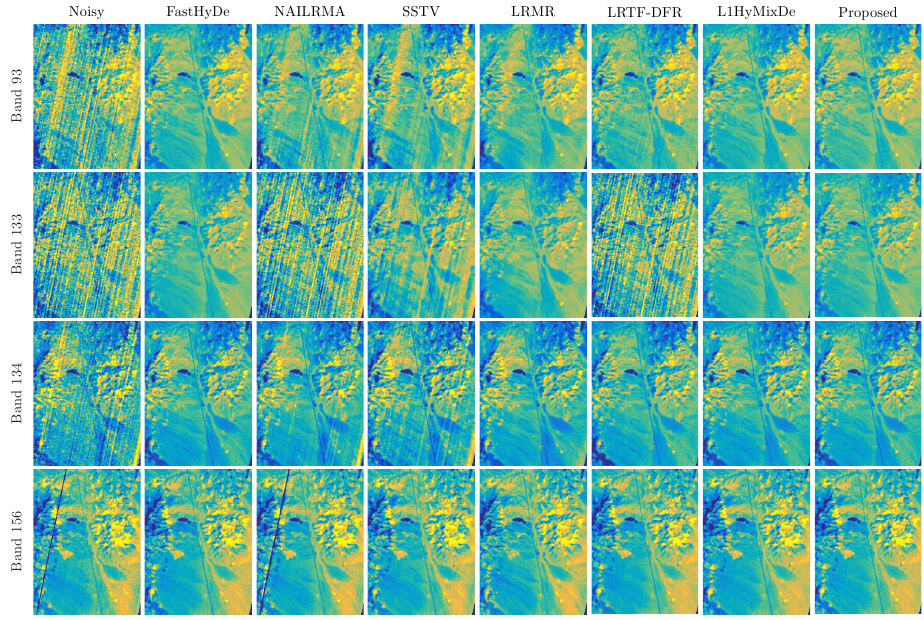
Figure 11. Bands 93, 133, 134, and 156 of the Hyperion Cuprite data before and after